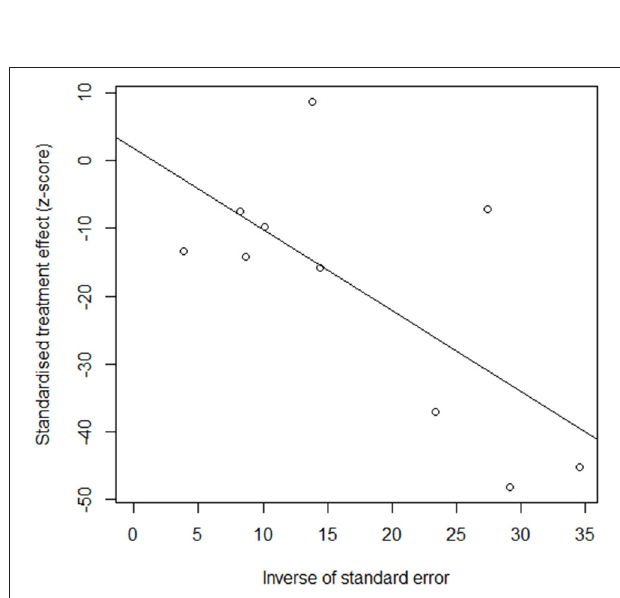
FIGURE 8 | Funnel plot of publication